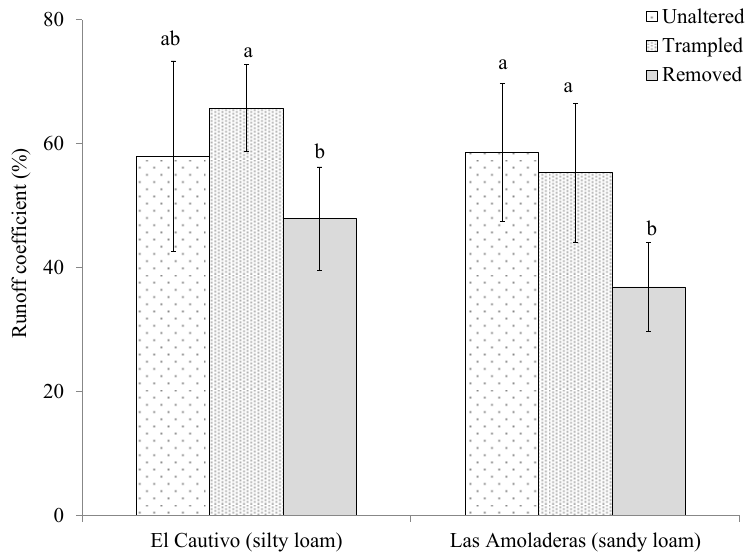
Figure 4. Runoff coefficient (%) in unaltered, trampled and removed well-developed cyanobacterial biocrusts after 1 h of rainfall simulation with a constant intensity of 50 mm h − 1 , on silty loam (El Cautivo) and sandy loam (Las Amoladeras) soils. Different letters indicate significant differences ( p < 0.05) among treatments at each site. Table 2. Characteristics of rainfall events and runo ff coe ffi cients (mean ± SD, n = 3) measured in the plots with incipient and well-developed cyanobacterial biocrusts, at the di ff erent scales at El Cautivo